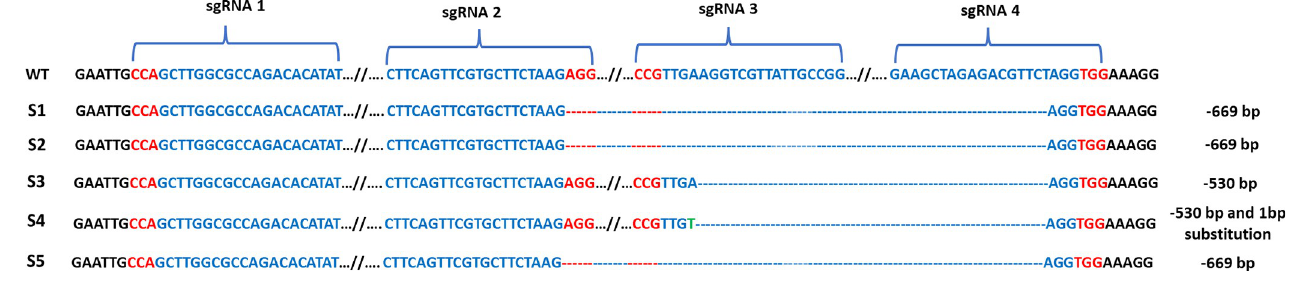
Fig 6. Sanger sequencing results of the VgPDS gene derived from cowpea protoplast after PEG mediated transformation. sgRNA 1, sgRNA 2, sgRNA 3 and sgRNA 4 positions are indicated. PAM sequences are highlighted in red letter. WT indicates wild type that was not edited. Dash lines ( — ) are the deleted nucleotides.